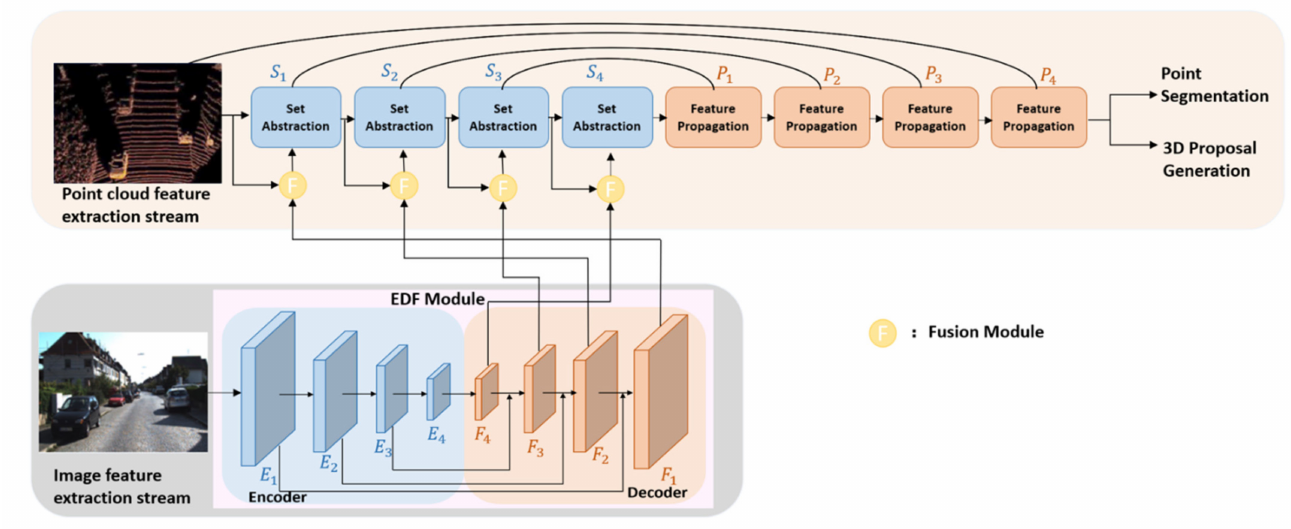
Figure 1. The overall architecture of